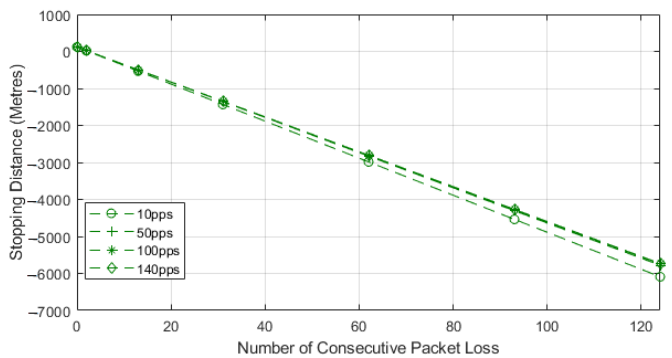
Figure 19. Seventy miles per hour (112.63 km/h) reduction in stopping